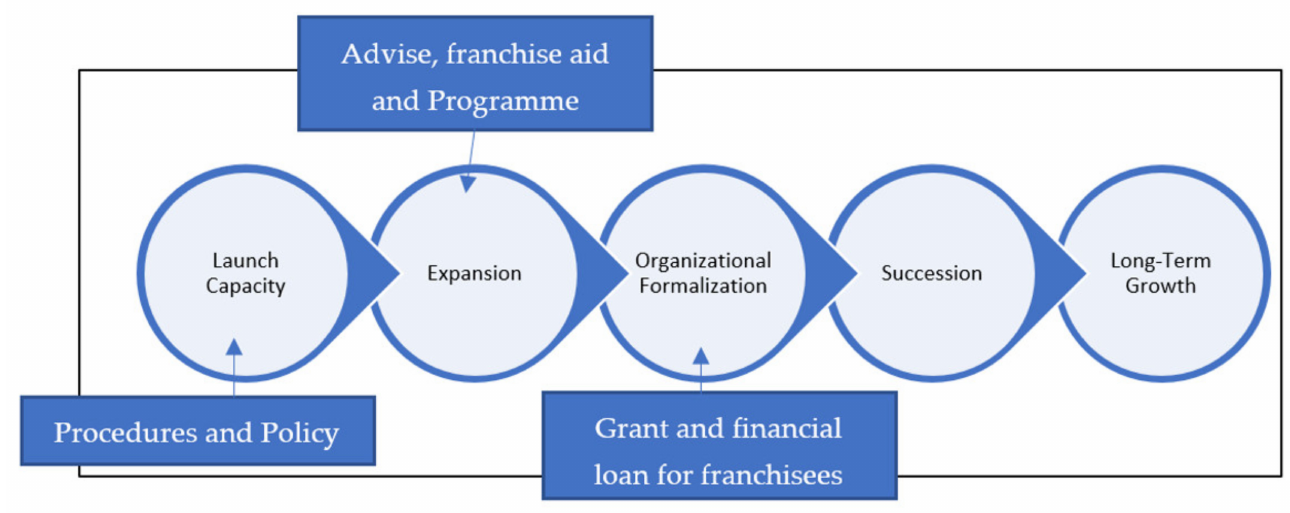
Figure 2. Government Support Contribution on Crossing Chasms Stages of Growth